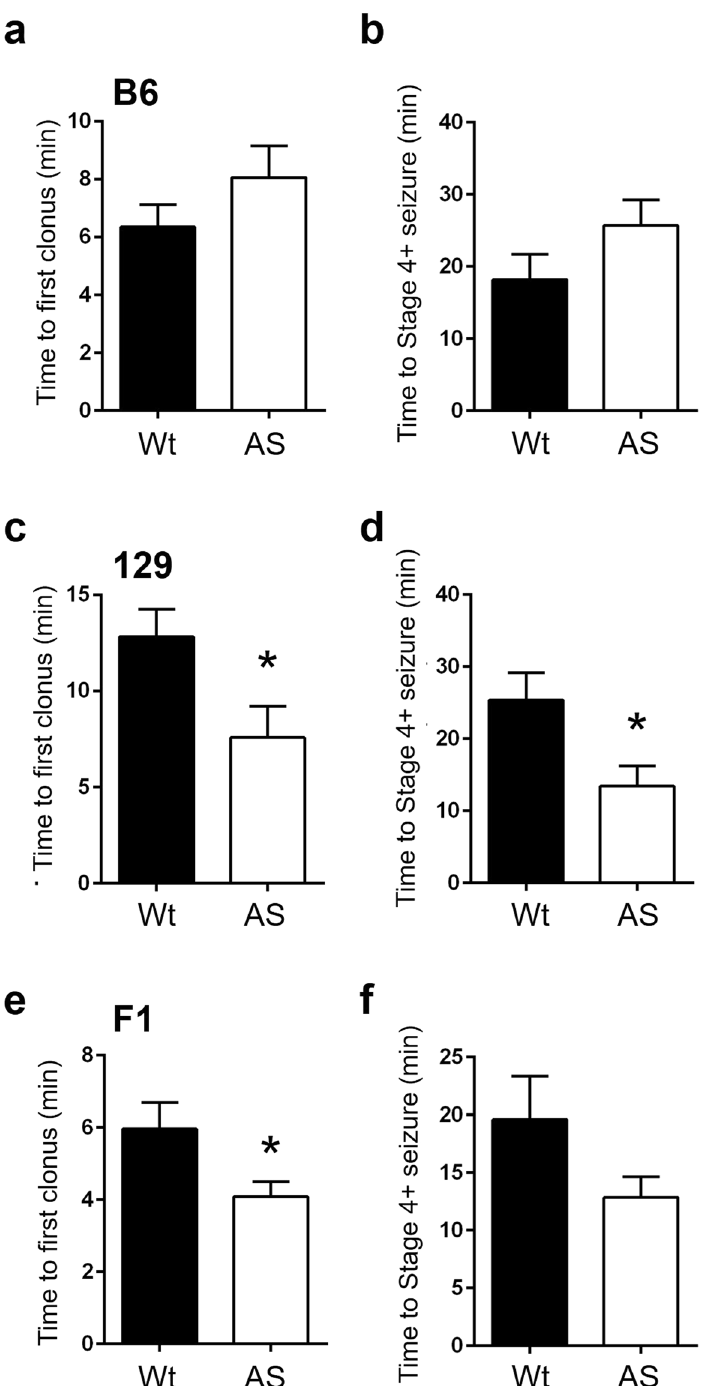
Figure 7. Seizure induction with KA. ( a,b ) KA induction (25 mg/kg) in Wt and AS mice in the B6 background (n = 12–13 / group). No significant difference was found between B6 Wt and AS mice for time to reach the first clonus (tail/head/limbs) ( a ) or time to reach stage 4 or greater seizure ( b ). ( c,d ) KA induction (40 mg/kg) in Wt and AS mice in the 129 background (n = 11–12 / group). 129 AS mice exhibited a significantly lower latency to reach the first visible clonus of tail/head/limb ( c ) and stage 4 or greater seizure ( d ) compared to Wt littermates. ( e,f ) KA induction (35 mg/kg) in Wt and AS mice in the F1 background (n = 11–12 / group). F1 AS mice exhibited a significantly lower latency to reach the first visible clonus of tail/head/limb ( e ) compared to their Wt littermates. No significant difference was found between F1 Wt and AS mice for latency to stage 4 or greater seizure ( f ). Data are presented as the mean ± SEM; Student’s t-test was used to compare between AS and Wt mice; n = 11–13 mice/group; * p <